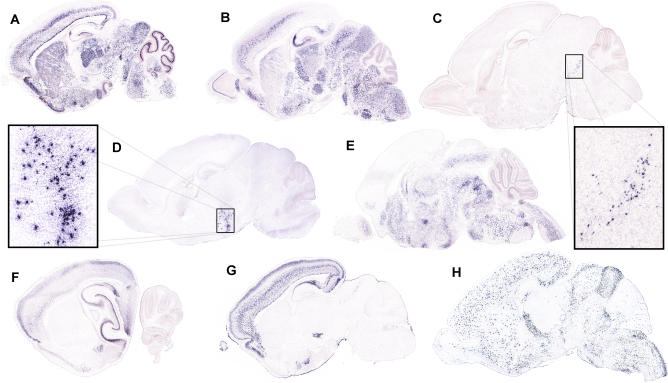
Examples of Gene Expression PatternsShown are gene expression patterns revealed by nonradioactive robotic ISH on sagittal sections. Digoxigenin-tagged RNA probes hybridized to cellular mRNA are visualized via a serial amplification that produces a blue-purple signal.(A) Purkinje cell protein 4 in section 4.(B) Ly6/neurotoxin 1 in section 6.(C) 4931408A02Rik in section 9 with inset showing localized expression in midbrain neurons.(D) A230109K2Rik in section 9 with inset showing localized expression in hypothalamus.(E) RAS protein-specific guanine nucleotide-releasing factor 1 in section 11.(F) Gastrin releasing peptide in section 2.(G) Nephroblastoma overexpressed gene in section 4.(H) Somatostatin in section 6.